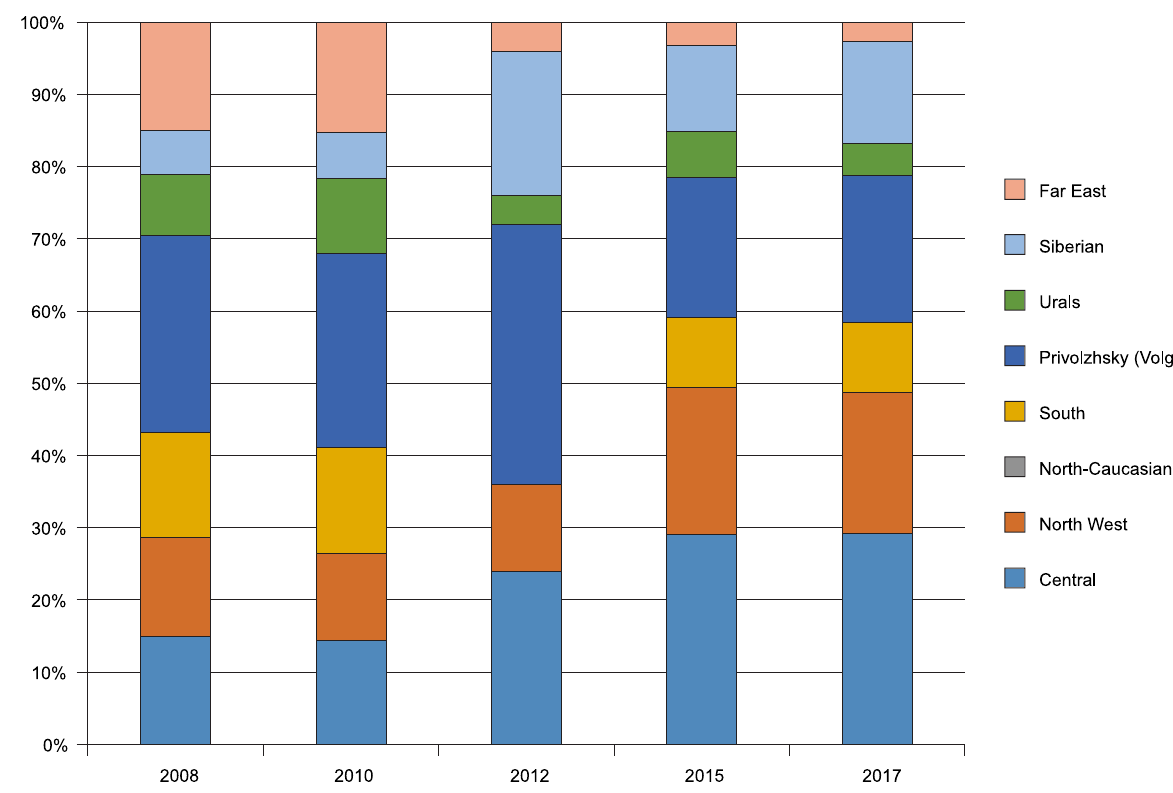
Fig. 1. Spatial distribution of clusters in the federal districts of Russia (2008–2017).